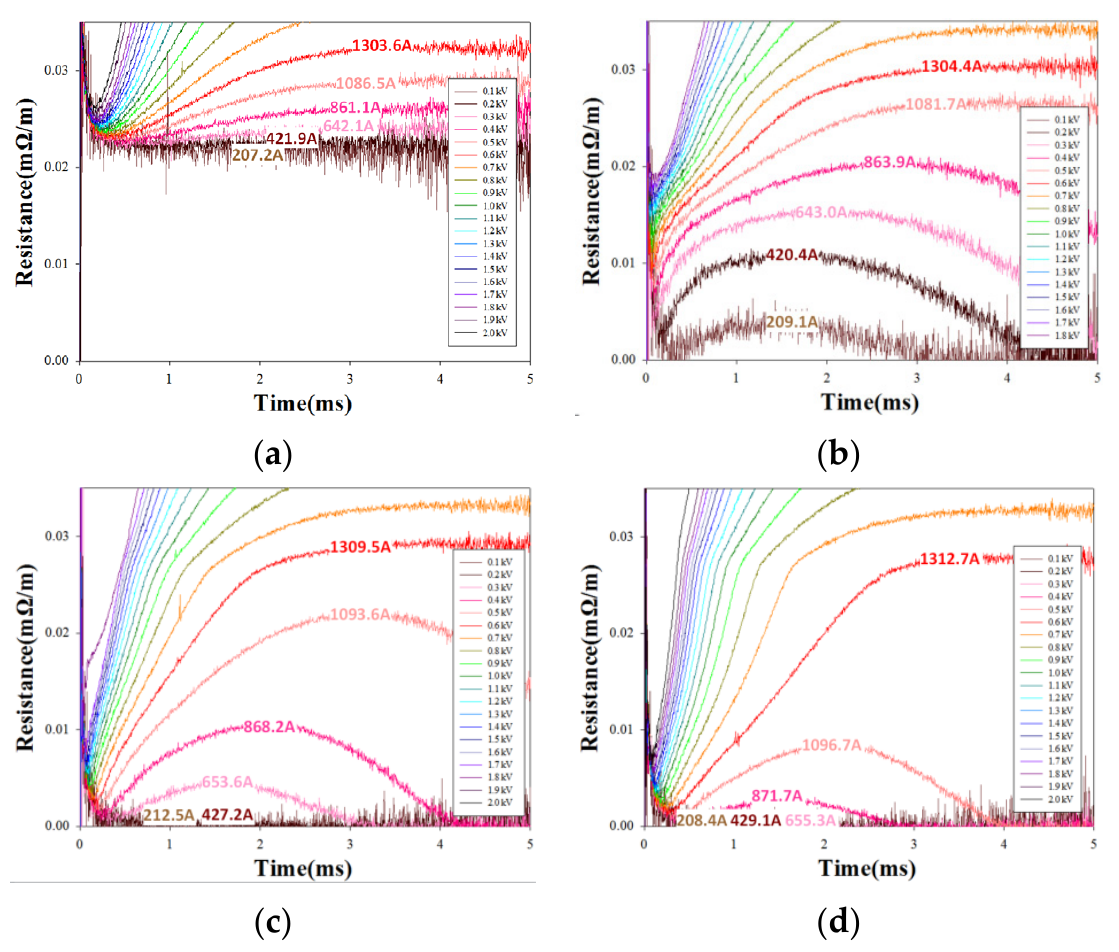
Figure 14. Impulse resistance responses of samples ( a ) sample 1; ( b ) sample 2; ( c ) sample 3; ( d ) sample 4.